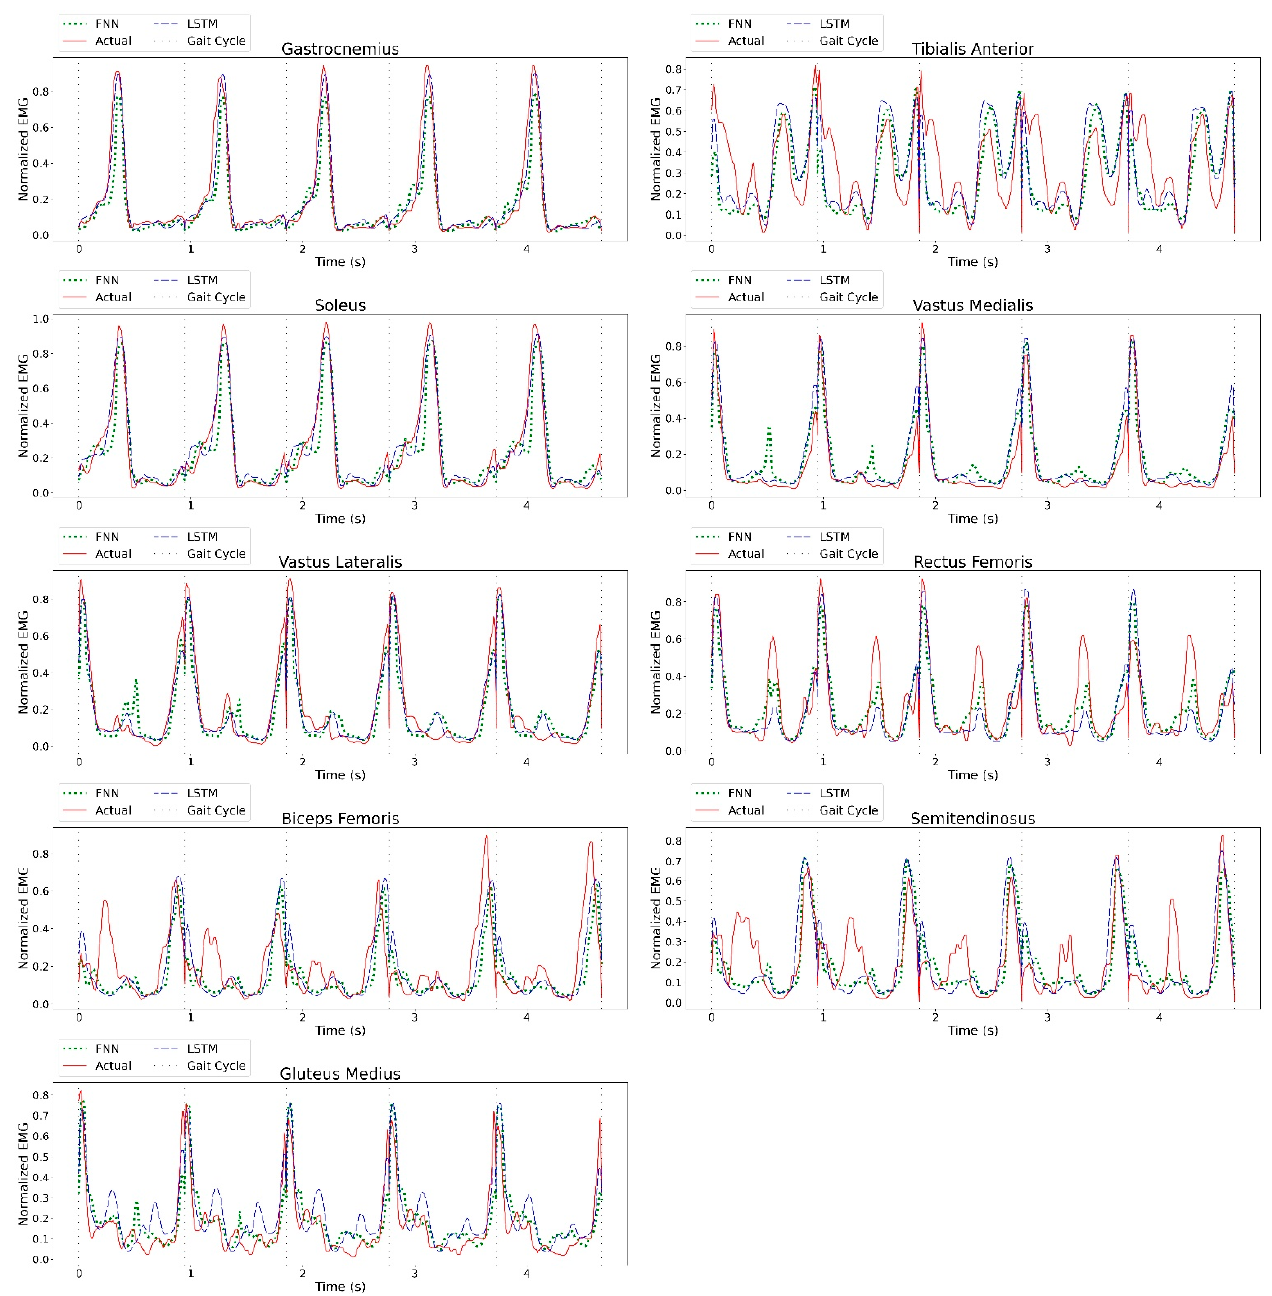
Figure A6. A plot of actual vs. predicted muscle activities of the unseen data (Sample C).